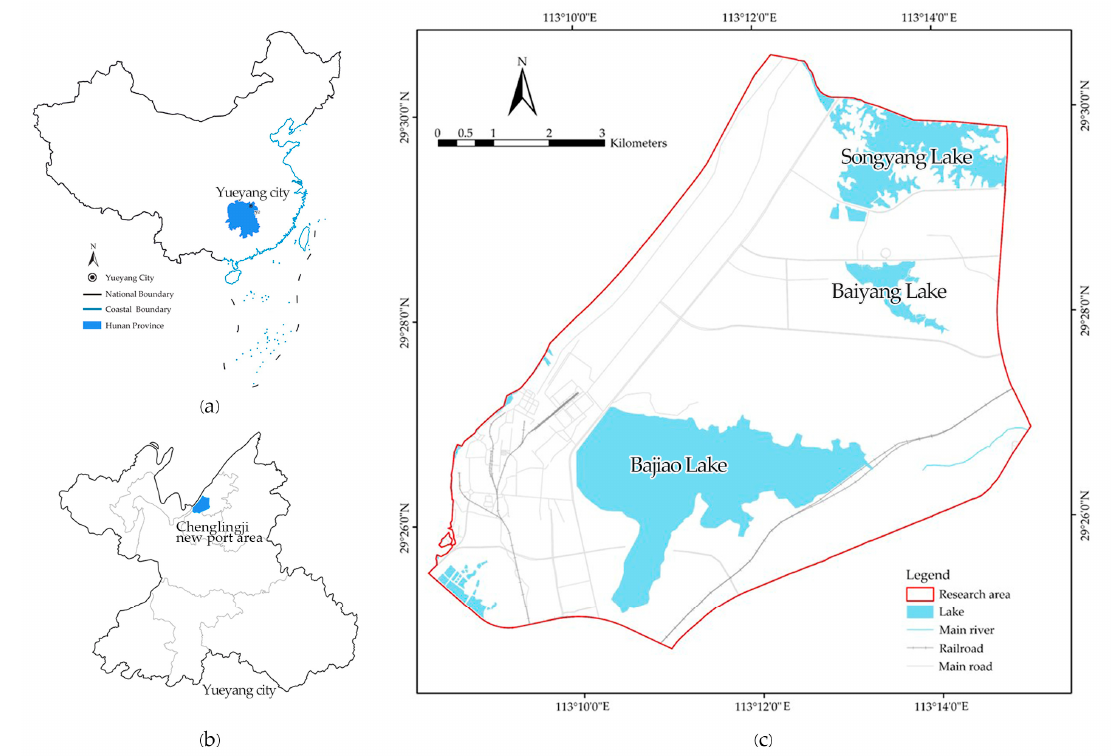
Figure 3. Location of Chenglingji new port area. Note: ( a ) Yueyang City’s location in China and Hunan Province; ( b ) location of Chenglingji new port area in Yueyang City; ( c ) Chenglingji new port area.